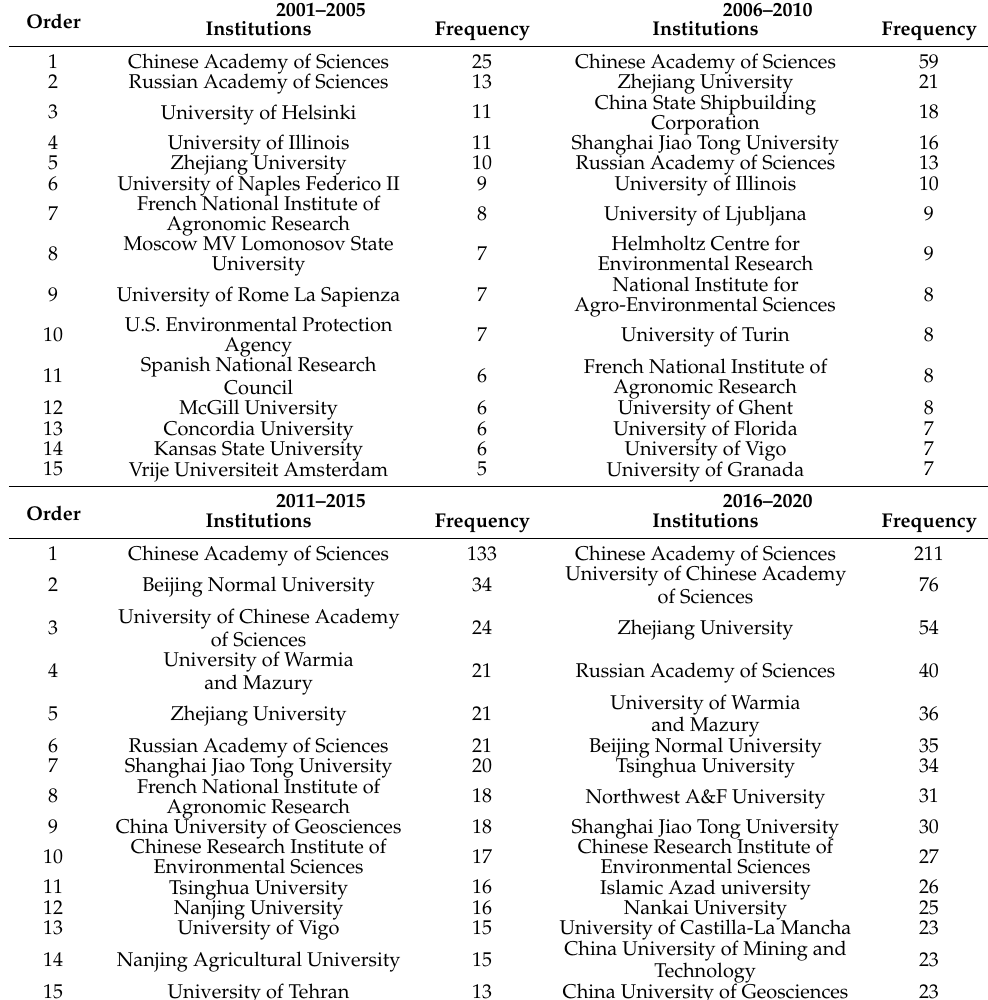
Table 2. Top 15 institutions and frequency of papers